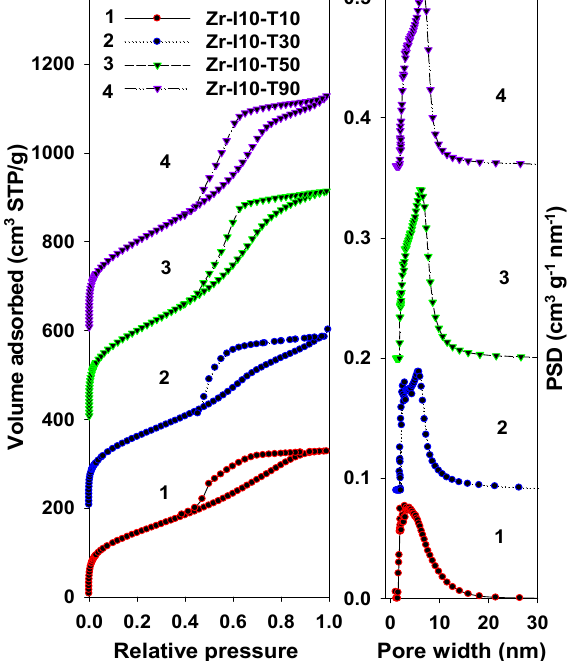
V sp —single ‐ point ‐ pore volume determined at the relative pressure of 0.98; V mic —volume of fine pores (micropores and mesopores <3 nm) calculated by integration of PSD curve up to 3 nm; S BET — specific ‐ surface area calculated from adsorption data, in relative ‐ pressure range 0.05–0.20; W max — pore width calculated at the maximum of PSD, using an improved KJS method.